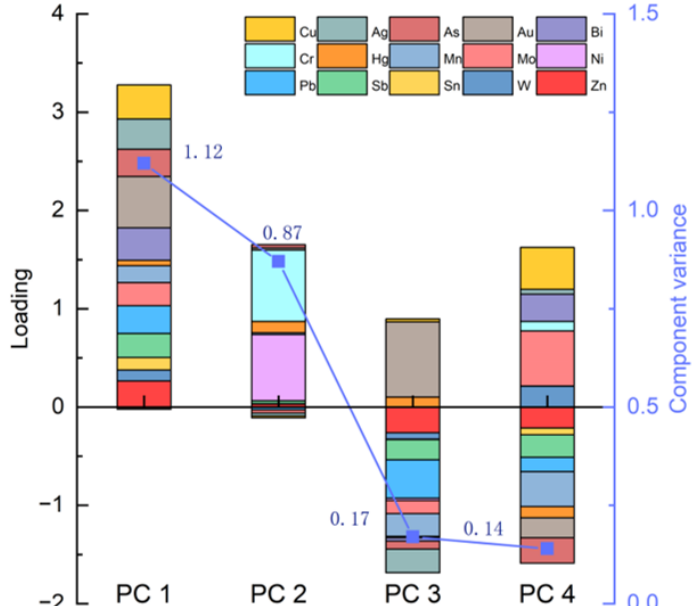
Figure 11. The loading and component variance of each PC.